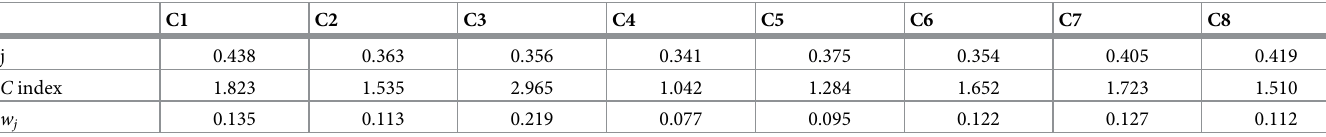
, C index and criterion weights w j